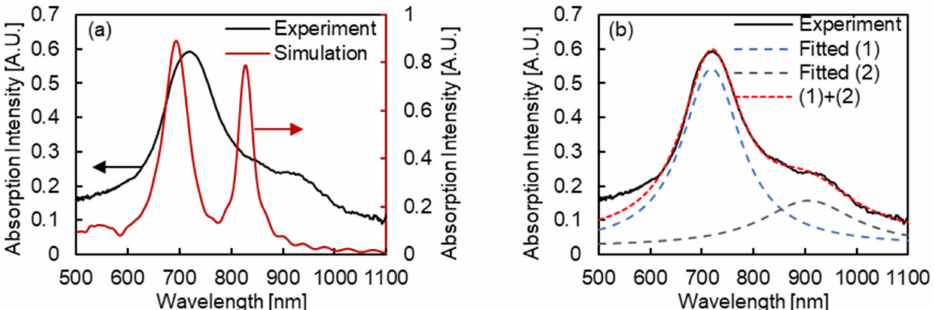
Figure 6. ( a ) Experimental absorption spectrum of fabricated MIM nanostructures and simulated in one of MIM nanostructures imitating the SEM images (140 nm of bottom diameter and 70 ◦ slope). The black line indicates the experimental absorption spectrum, and the red line indicates the simulated one. ( b ) Experimental absorption spectrum of fabricated MIM nanostructures and the Lorentz functions fitted to the spectrum. The black line indicates the experimental absorption spectrum, the blue and black dashed lines indicate the fitted Lorentz functions, and the red dashed line indicates the sum of two Lorentz